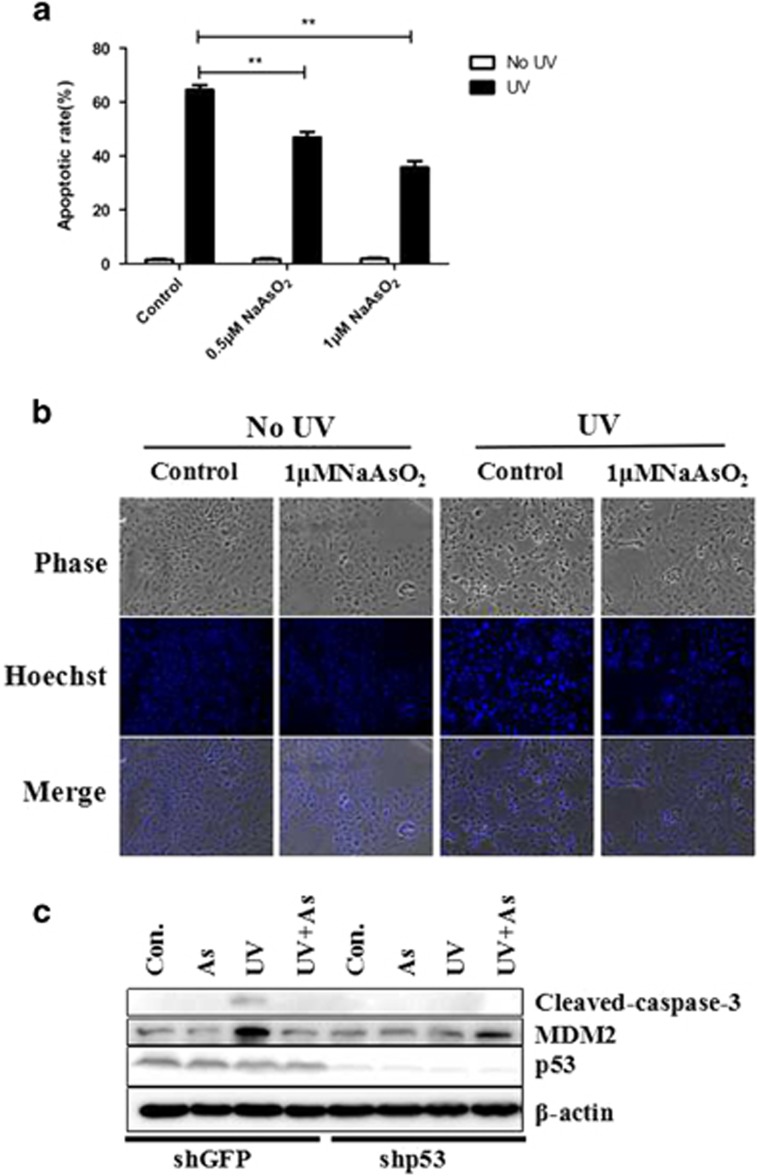
Arsenic treatment decreases cellular apoptosis induced by UV exposure. (a) The cellular apoptotic rate determined by flow cytometry. When cells were not exposed to UV irradiation, the rate of keratinocyte apoptosis was low, regardless of whether the cells had been pretreated with sodium arsenite. However, upon UV exposure, the apoptotic rate of control keratinocytes increased, while the cells pretreated with sodium arsenite did not experience the same extent of apoptosis. (b) Cell morphology detected by phase-contrast microscopy, after Hoechst 3258 staining. When cells were not exposed to UV, there was no change in morphology even in cells pretreated with sodium arsenite. When the keratinocytes were exposed to UV, pyknosis of nuclei and nucleosomes was observed. Pretreatment with sodium arsenite decreased the incidence of pyknosis. (c) After the knockdown of p53, the expression of apoptotic markers was detected by immunoblotting.